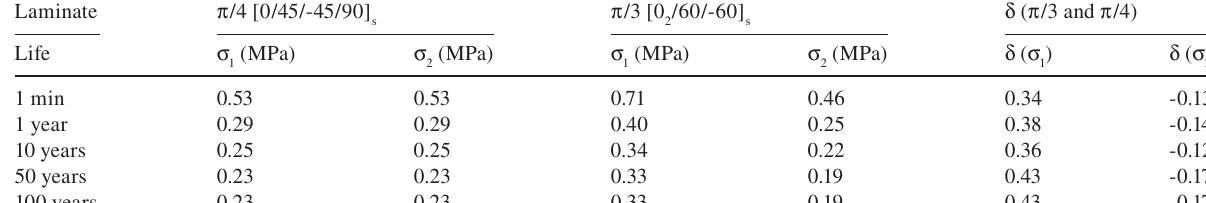
Table 1 Tensile σ Laminate